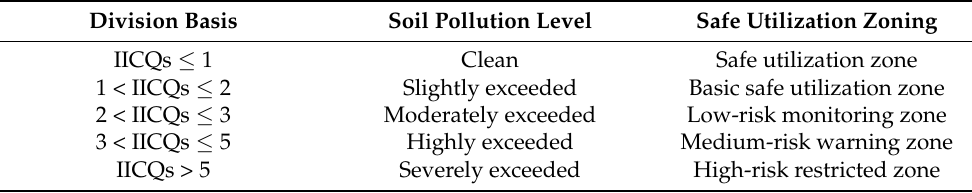
Table 1. Classification of soil environmental quality and safe utilization. Division Basis Soil Pollution Level Safe Utilization Zoning IICQs ≤ 1 Clean Safe utilization zone 1 < IICQs ≤ 2 Slightly exceeded Basic safe utilization zone 2 < IICQs ≤ 3 Moderately exceeded Low-risk monitoring zone 3 < IICQs ≤ 5 Highly exceeded Medium-risk warning